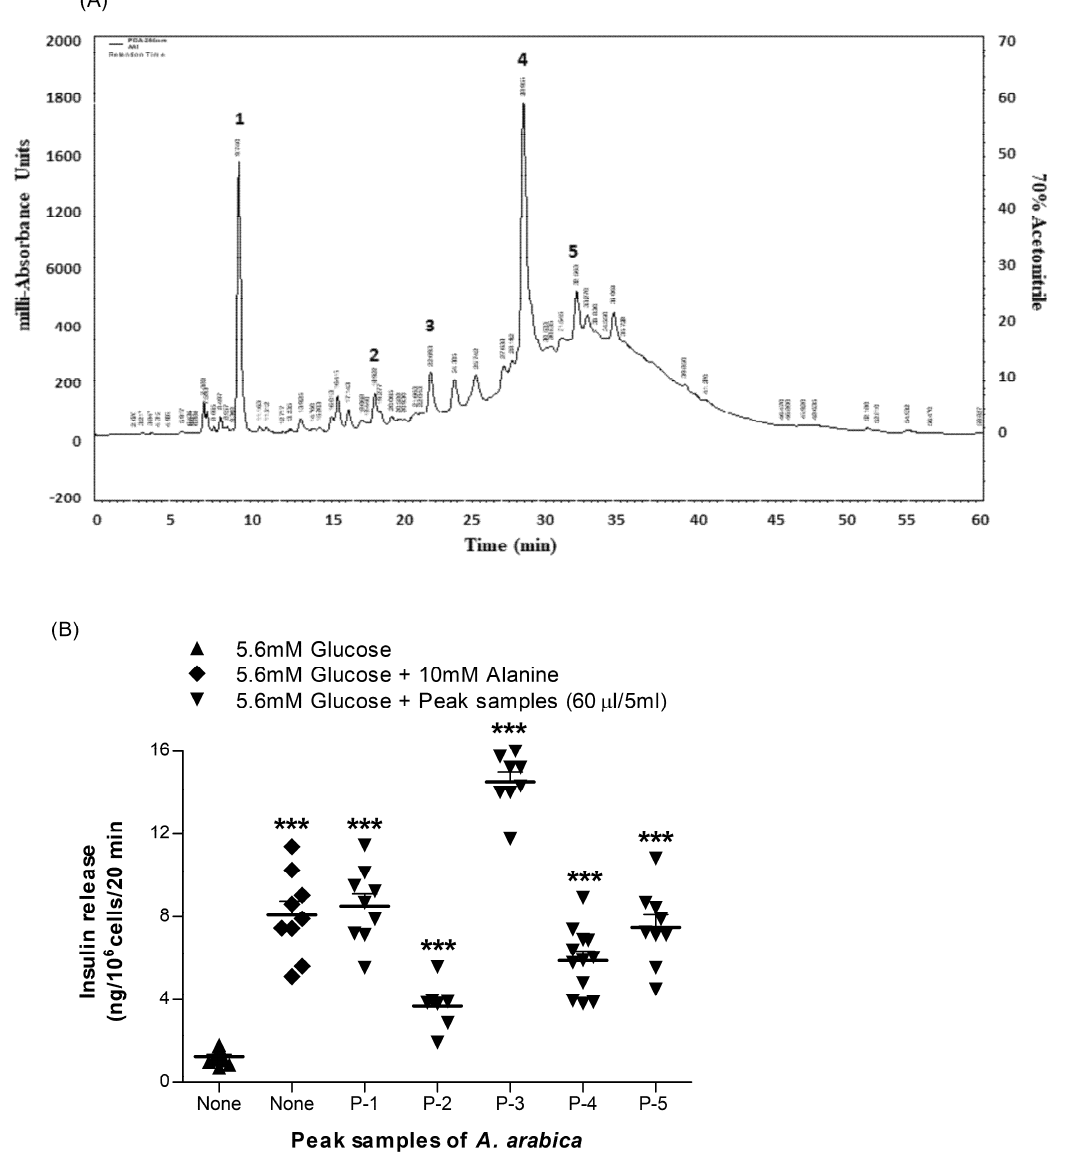
Figure 7. Representative ( A ) HPLC profile and ( B ) insulin-releasing effects in BRIN BD11 cells of peak samples (1–5) of hot-water extract of A. arabica bark. The crude extract was chromatographed at a flow rate of 1.0 mL/min on a (10 × 250 mm) semipreparative 5 µ m C-18 column (Phenomenex, UK). The concentration of the eluting solvent was raised using linear gradients of acetonitrile (0–20% from 0 to 10 min, 20–70% from 10 to 40 min and 70–20% from 40 to 60 min). Compounds were detected by measurement of absorbance at 254 nm, and major peaks labelled P1-P5 were assessed for insulin-releasing activity. Values are the mean ± SEM for n = 8. *** p < 0.001 compared to control.